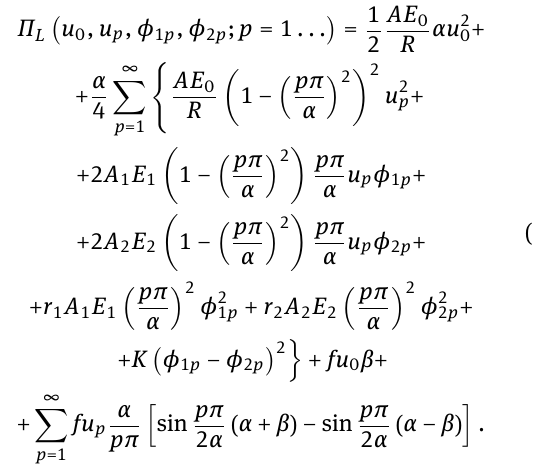
show the graphs of deflection and cross-sectional rotation functions. The normal force as a function of φ is shown in Fig. 8. The graphs of shear force function S = S ( φ ) and bending moment function M = M ( φ ) are illustrated in Figs. 9 and